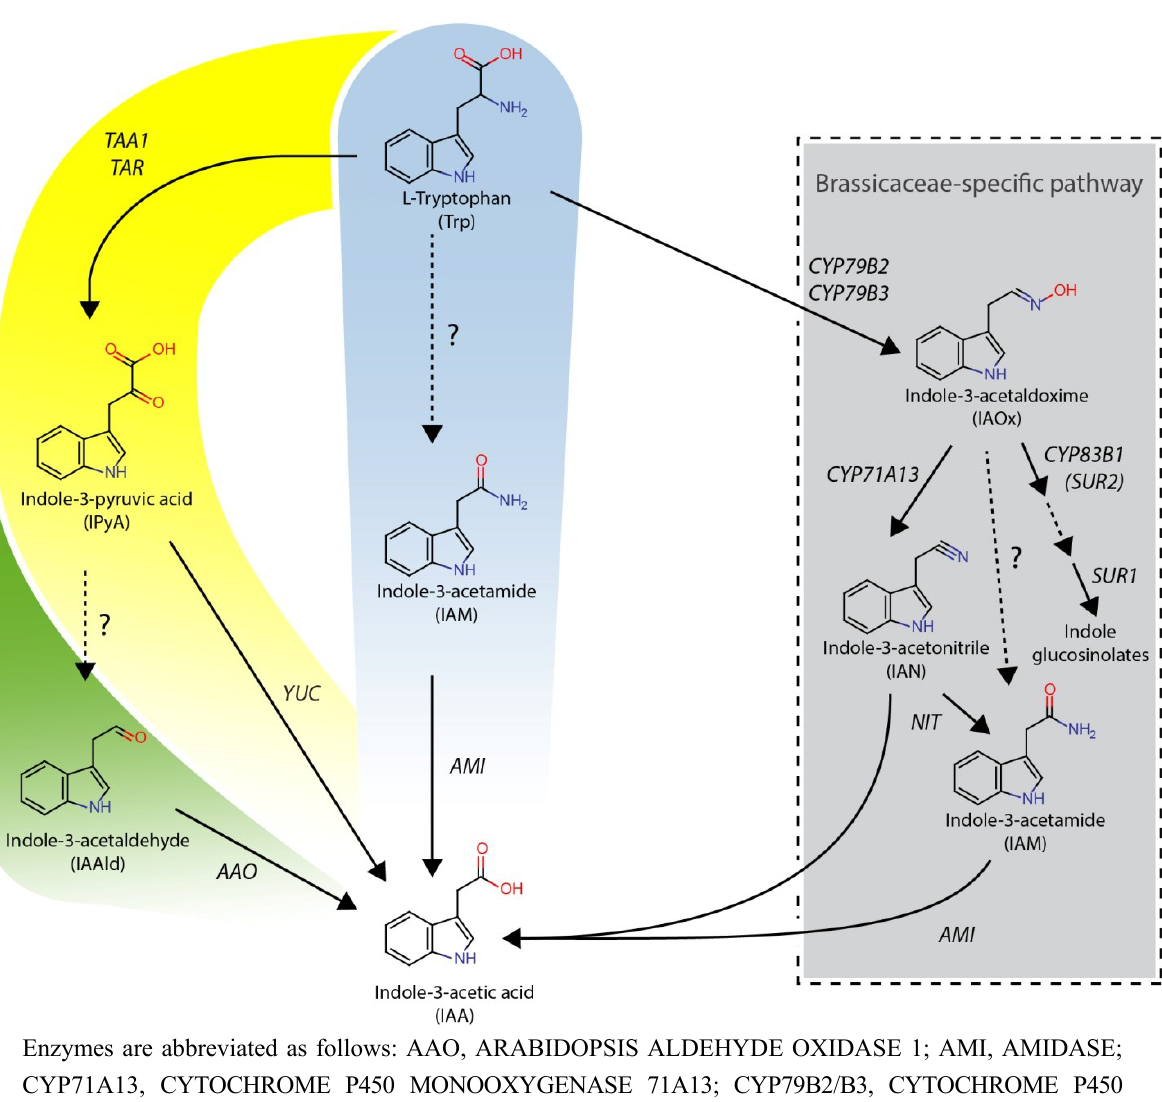
Figure 1. Proposed pathways of L-tryptophan-dependent IAA biosynthesis in plants. The IAOx-pathway that is seemingly restricted to indole glucosinolate-producing plant species is given in the grey box. In yellow, the IPyA-pathway is shown; a possible side-branch (IAAld-pathway) is added in green to the IPyA-pathway. In the middle, the IAM-pathway is highlighted in blue. Dashed lines indicate assumed reaction steps for which the corresponding enzymes have yet to be